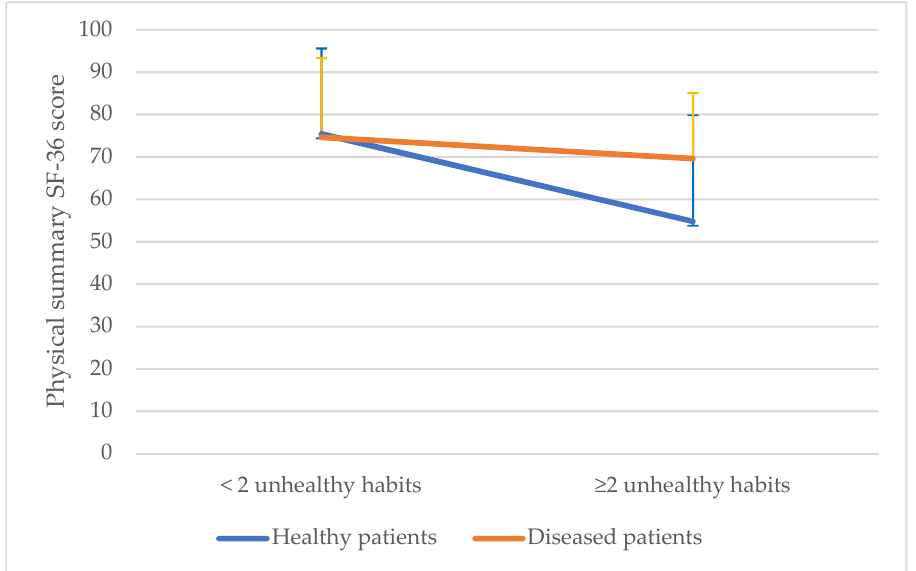
Figure 2. Interaction between morbidity and unhealthy habits in the prediction of SF-36 physical and mental summaries, adjusted by age and sex.